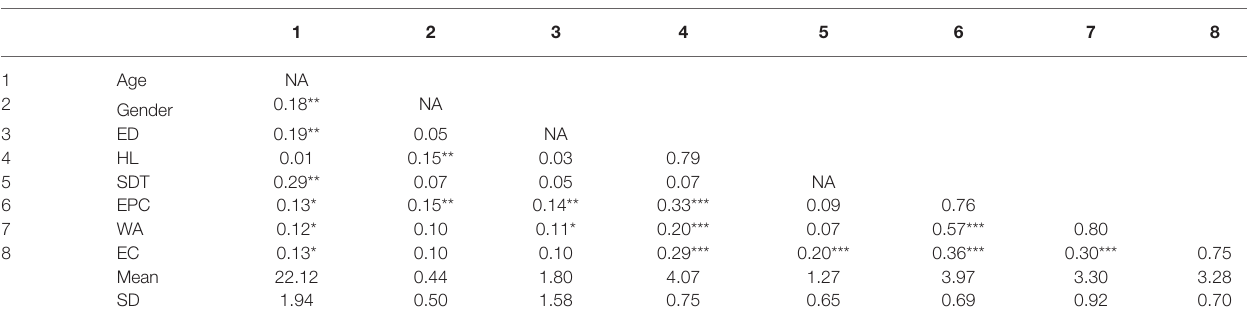
TABLE 1 | Descriptive statistics, correlations, and reliabilities ( N = 355).